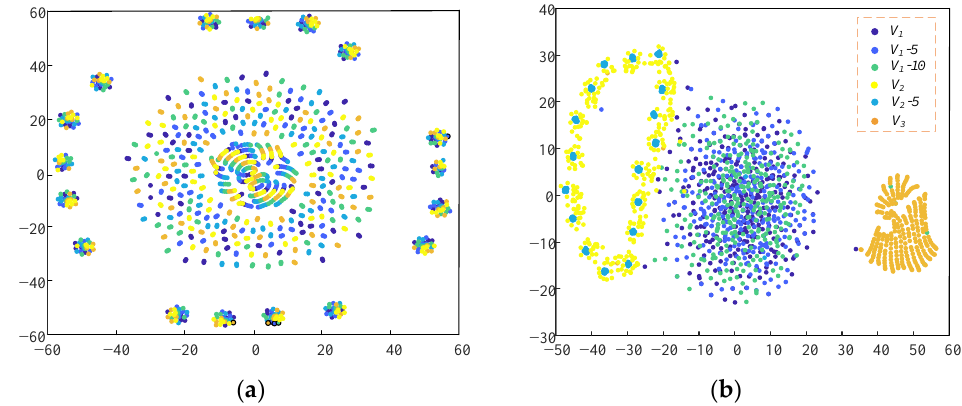
Figure 4. t-SNE reduces the dimension of the vibration signal and the implicit feature of the vibration signal. ( a ) t-SNE reduces the dimension of the vibration signal; ( b ) t-SNE reduces the dimension of the implicit feature of the vibration signal.